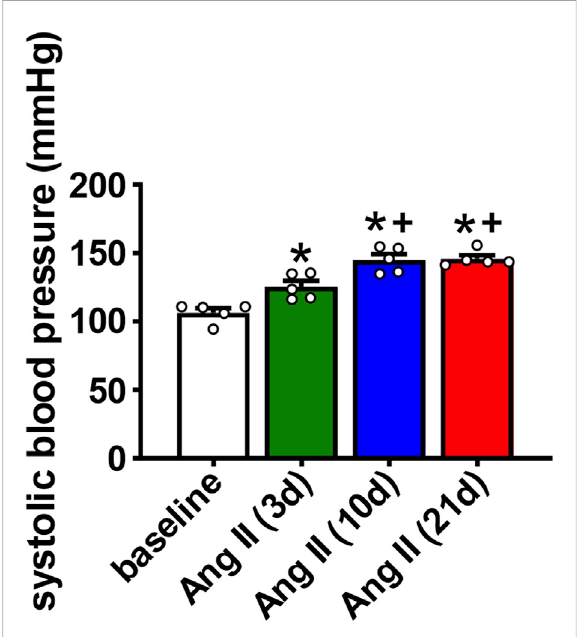
FIGURE 1 Time course of the effects of Ang II on systolic blood pressure. Systolic pressure was measured at baseline, 3 days, 10 days and 21 days of Ang II infusion. * p < 0.05 vs baseline; + p < 0.05 vs Ang II (3 days) by one-way repeated measures ANOVA with a Holm-Sidak posthoc test; n =5 mice per